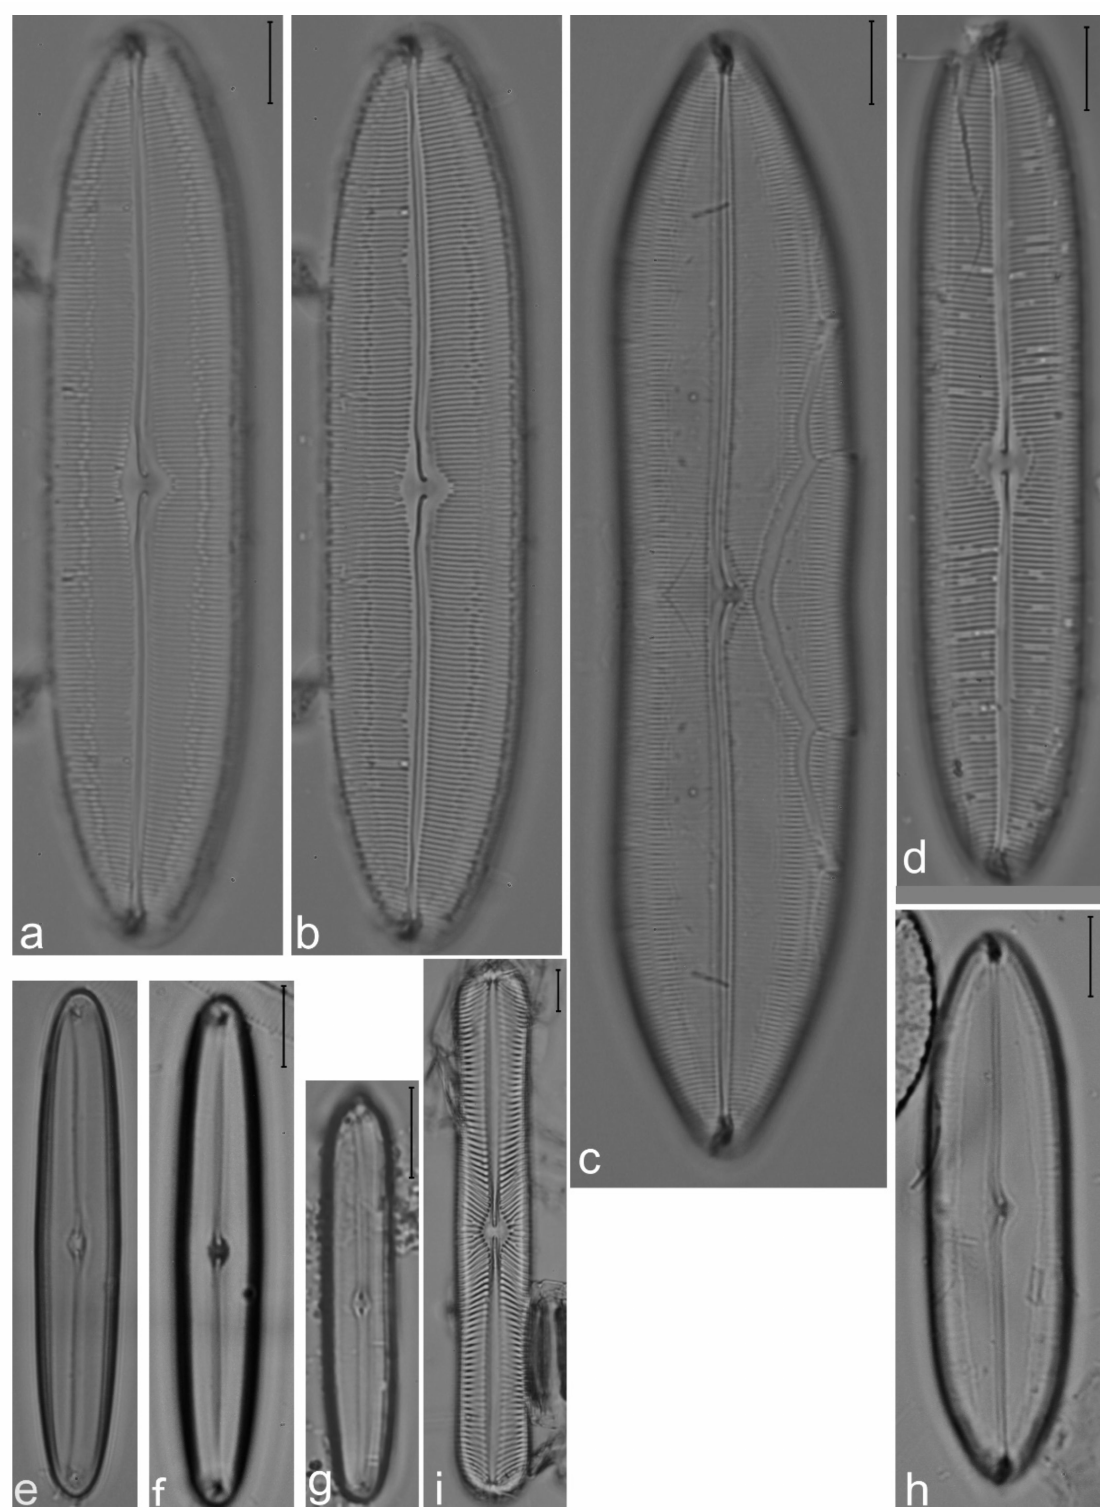
Figure 15. ( a – c ) Caloneis excentrica ; ( d ) C . liber var. umbilicata ; ( e – g ) C . linearis ; ( h ) C . bicuneata ; ( i ) Pinnularia cf. rectangulata . Scale bar = 10 µ